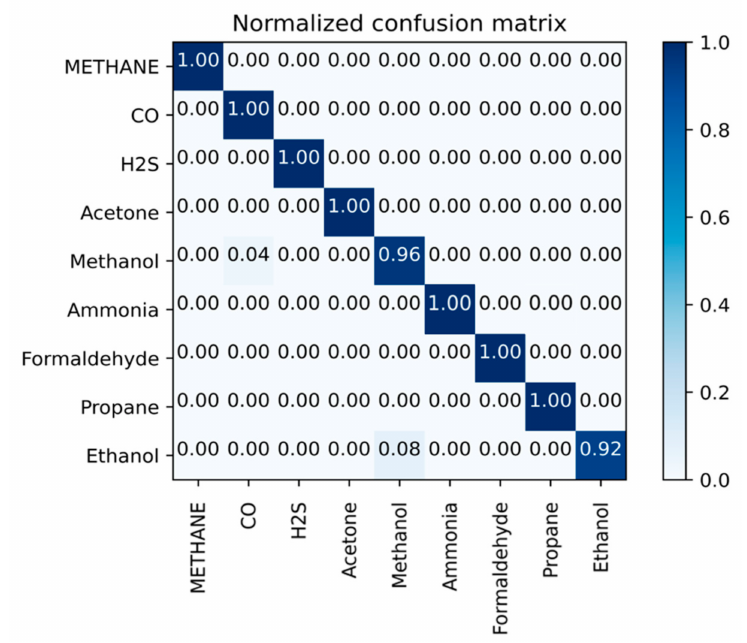
Figure 8. The confusion matrix for the accuracy of nine types of gases with the five-shot learning